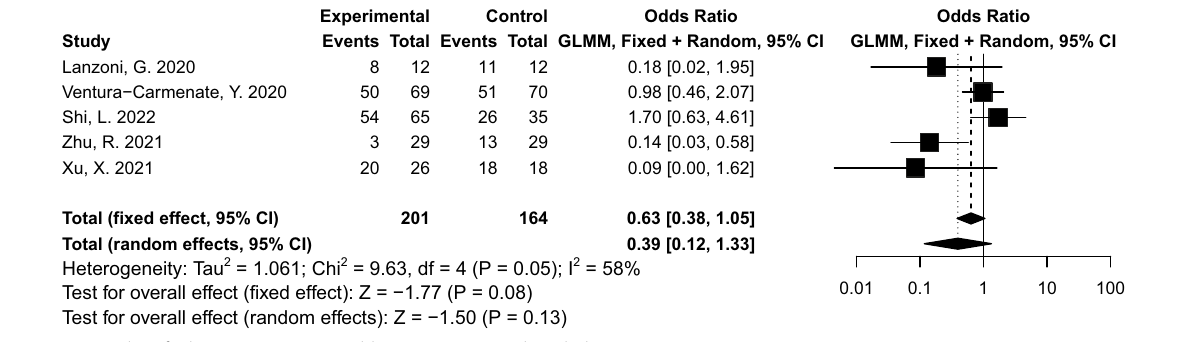
Fig. 2 Forest plot of adverse events (AEs): odds ratio (95% CI) and pooled estimates